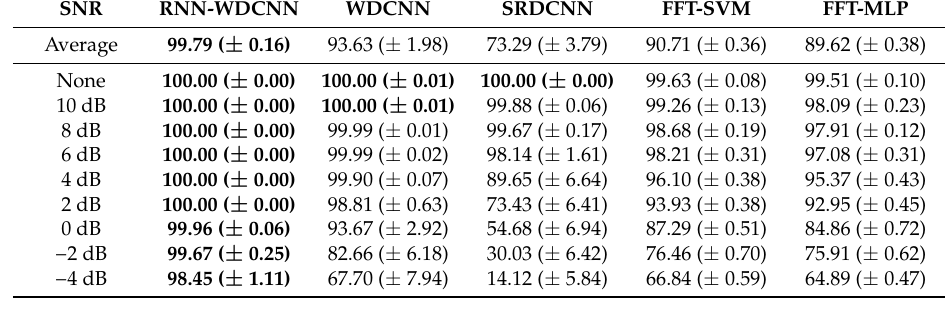
Table 15. F1 scores of the models considered in this work (as a percentage) for noise rejection performance (best values are highlighted in bold).